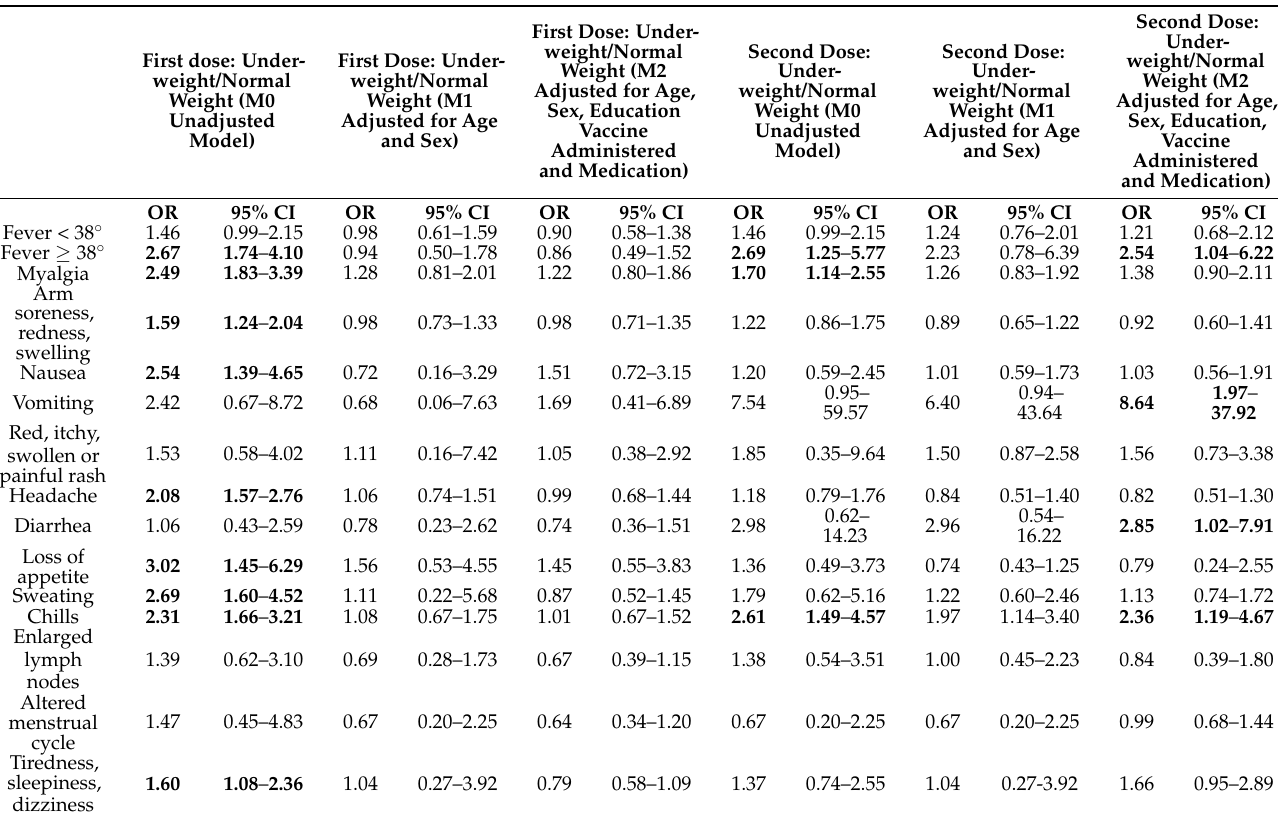
Table 5. Associations between weight status (reference: overweight/obese) and side effects experienced in the first and the second doses of COVID-19 vaccine. Results from Multinomial Logistic Regression